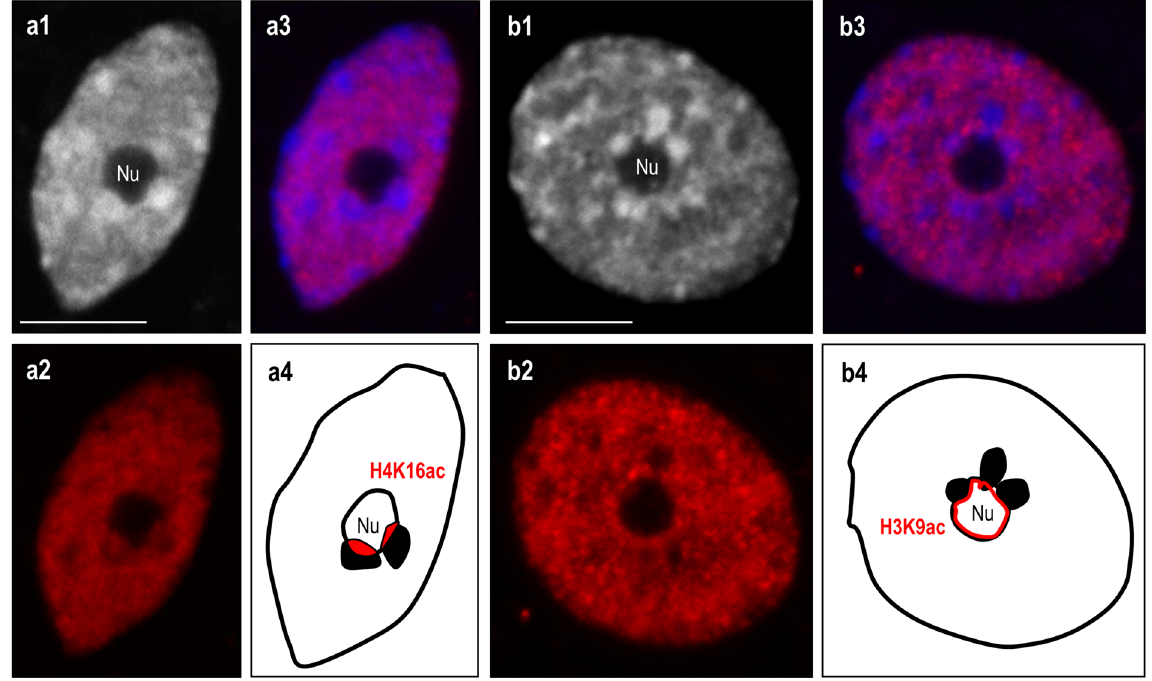
Figure 5. Immunopatterns of H4K16ac (a1–a4) and H3K9ac (b1–b4) in the nuclei isolated from B. hybridum roots. a1 , b1 –DAPI counterstained nuclei; a2 , b2 –histone immunopatterns; a3 , b3 –superimposed channels of particular histone modification foci distribution (red) and DAPI (blue); a4 , b4 –schematic representation of H4K16ac (a4) and H3K9ac (b4) foci distribution in the nucleolus and adjacent chromocentres. Nu – nucleolus. Scale bar: 5 µ